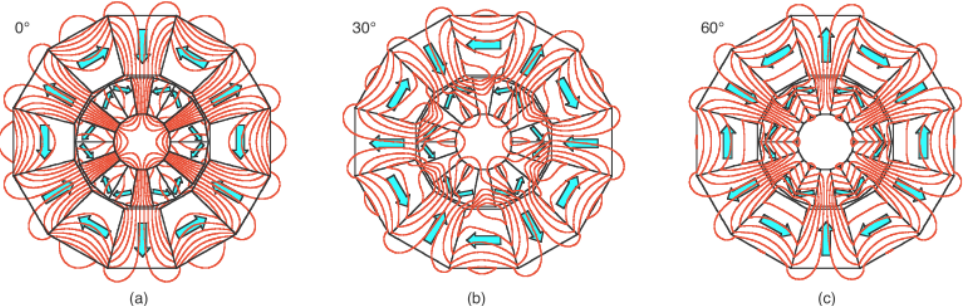
Figure 1. Schematic diagram of the mechanism of the Nest-Rot-SPM; ( a ) maximum strength position where the outer ring is in phase with the inner ring; ( b ) 30 ◦ rotated; ( c ) minimum strength position where the outer ring is out of phase (60 ◦ ). The arrows indicate the easy axes of the magnet pieces. The pieces without arrows are made of soft magnetic material. Reprinted with permission from Ref. [24] 2009, Elsevier.